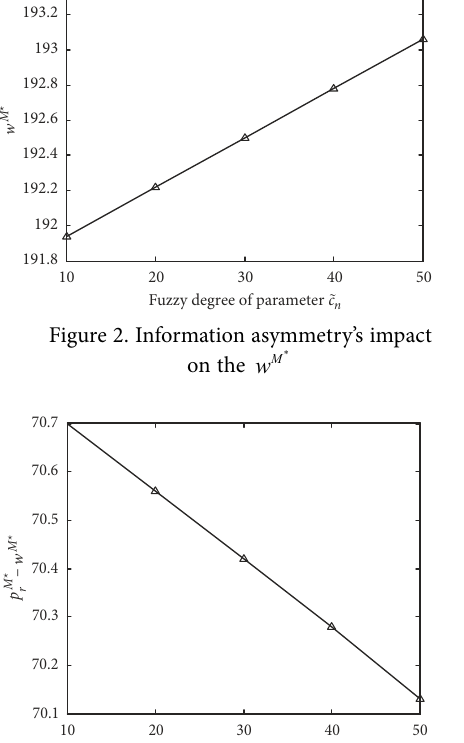
Figure 5. Information asymmetry’s impact on